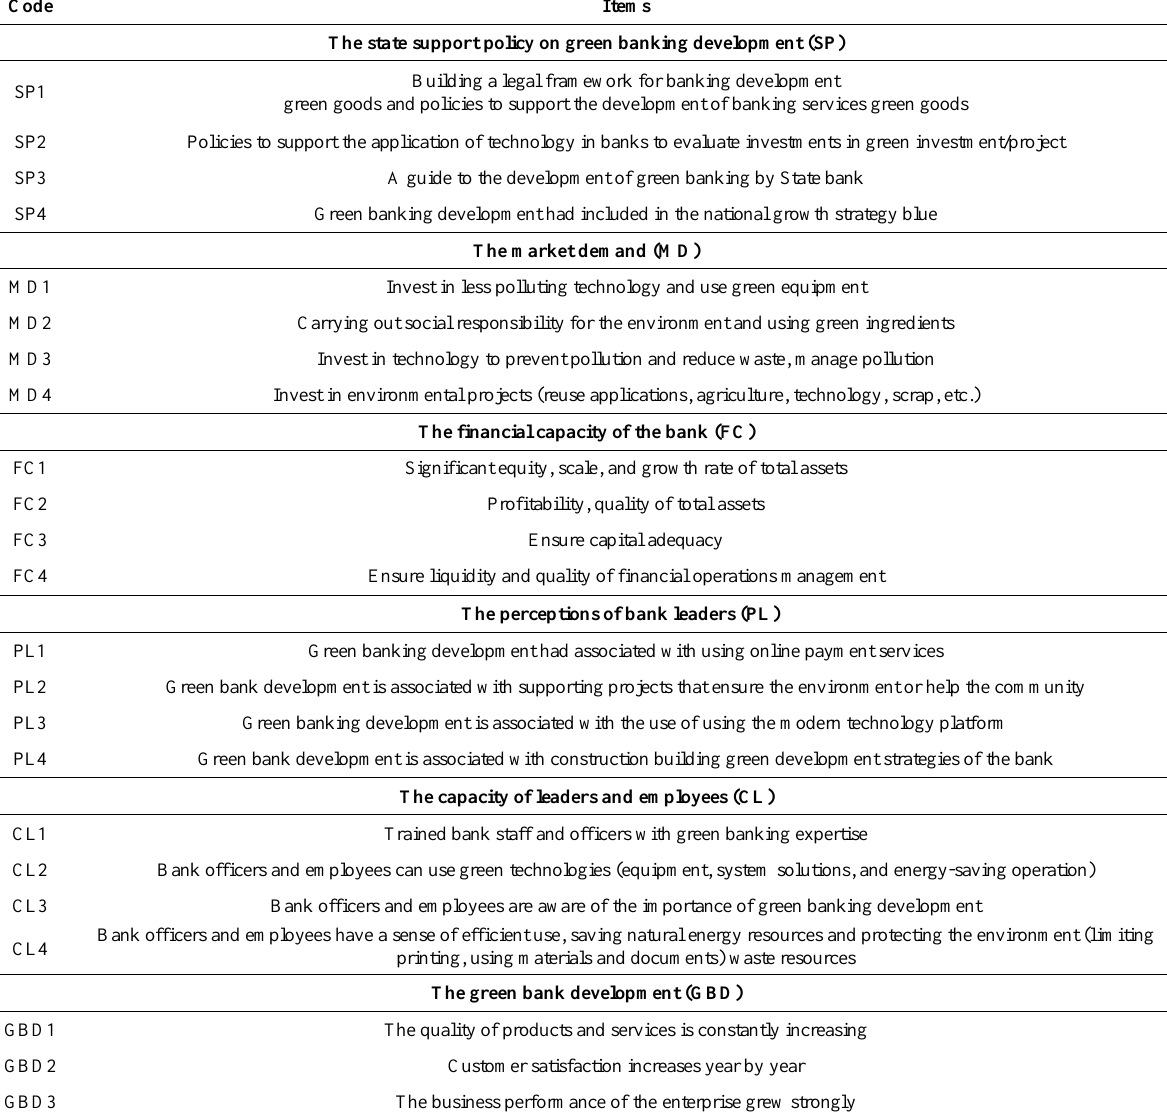
Table 5. The questionnaire for the green bank